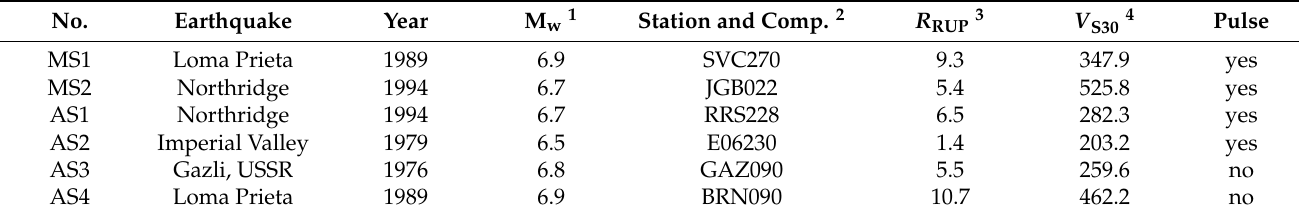
Table 4. Information of selected recorded near-fault ground motions in this